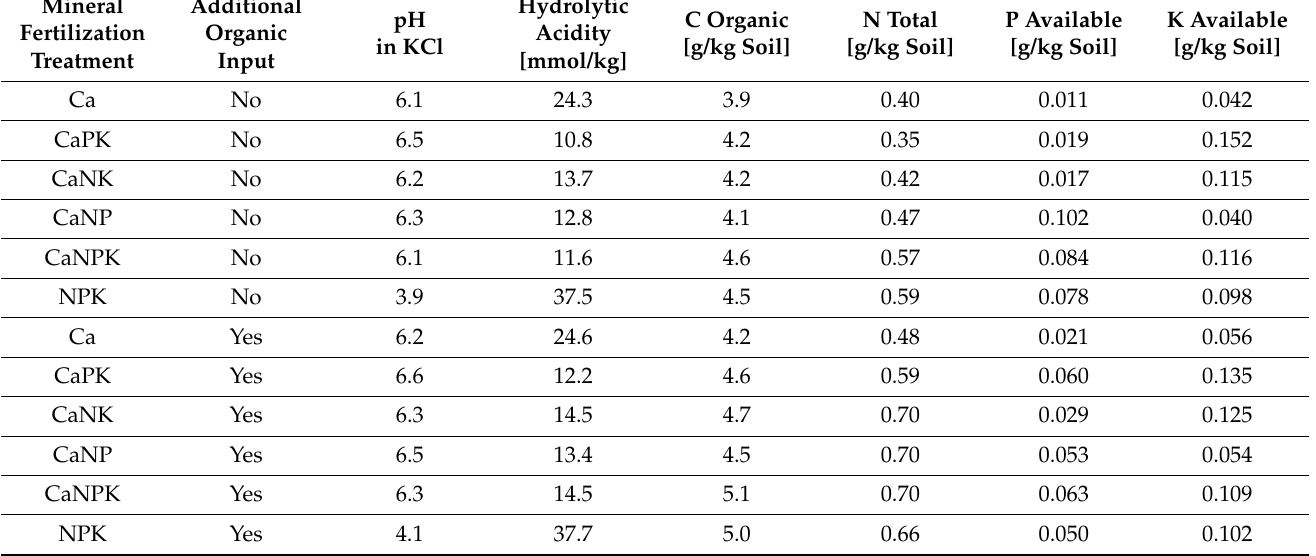
Table 1. Soil properties (at 0–25 cm depth) for the different fertilization treatments in the Skierniewice long-term experiment (LTE), as measured in